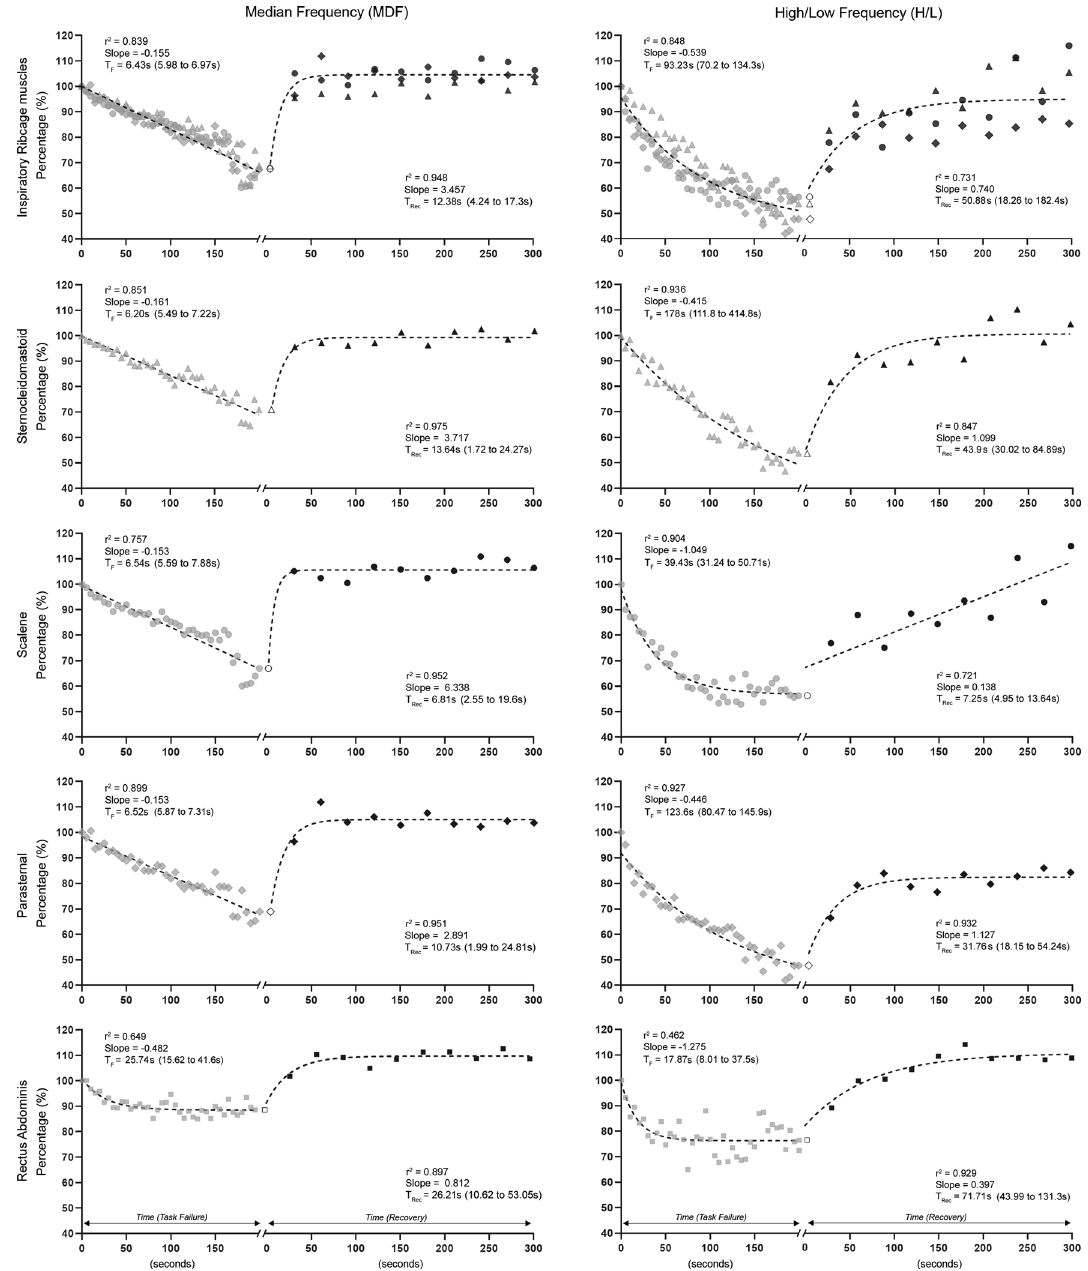
Figure 2. Time courses of normalized median frequency (left panels) and high/low ratio (right panels) of inspiratory ribcage muscles (mean values of the three inspiratory muscles studied), sternocleidomastoid (triangles), scalene (circles), parasternal (diamonds), and rectus abdominis (squares) muscles, respectively, during fatigue and recovery moments. Each point during the fatigue protocol (grey symbols) represents data averaged from 5 s, while during recovery (black symbols), each point represents data extracted from each SNIP maneuver (i.e., ten SNIP maneuvers with an interval of 30 s in between). All variables are normalized to their initial value during the fatigue protocol. In each muscle, the starting point at time zero (white symbols) corresponds to the last point of the fatigue protocol. Lines represent regression curves that fitted maximum values in a least-square sense, and equations are shown in Supplementary information 5. T F and T Rec represent the time constant during fatigue protocol and recovery, respectively, and numbers in parentheses are the 95% confidence interval. %: percentage; s: